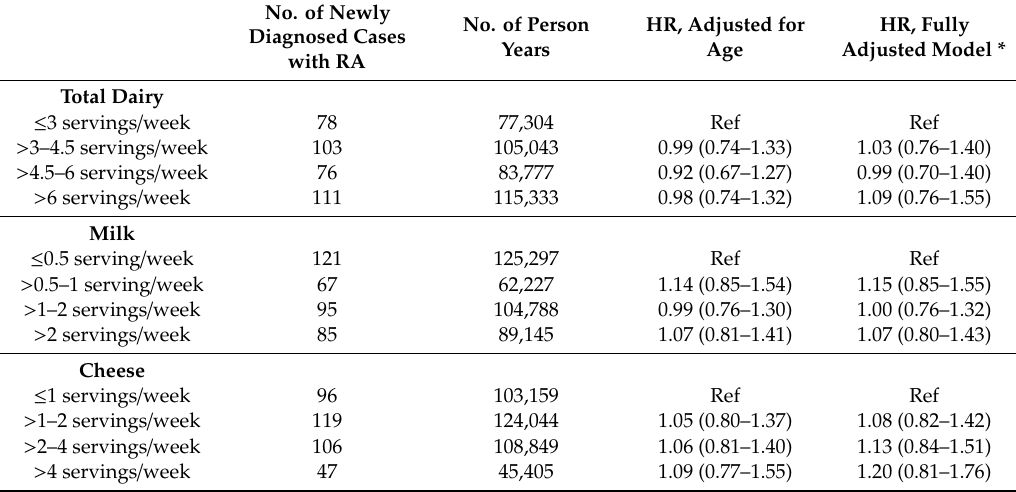
Table 3. Consumption of dairy and dairy products in 1997 and relative risk of developing rheumatoid arthritis (RA) among women in the Swedish Mammography Cohort during a 12 year follow-up period (January 2003–December 2014).